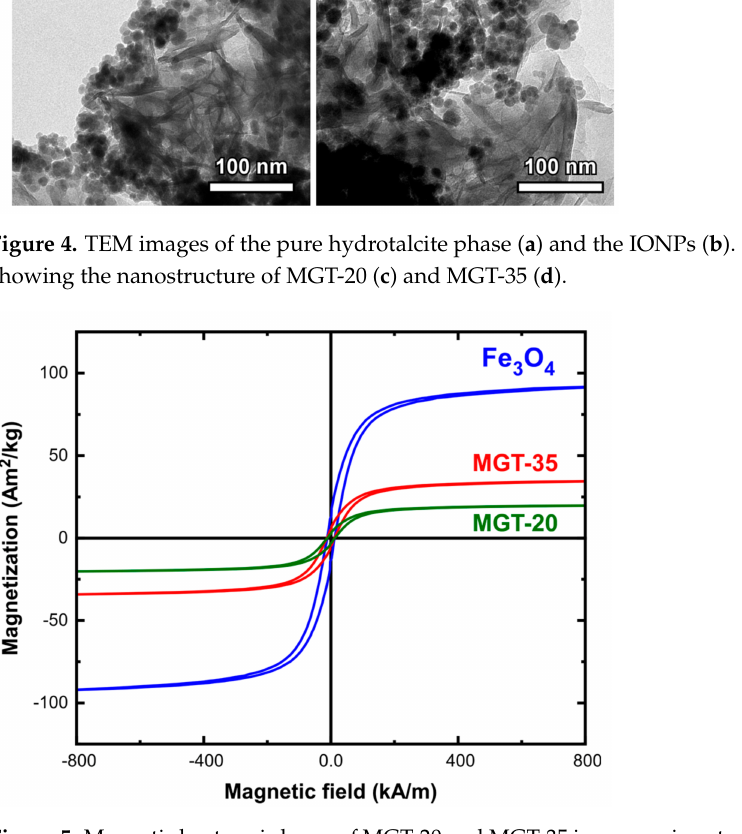
Figure 5. Magnetic hysteresis loops of MGT-20 and MGT-35 in comparison to the constituting